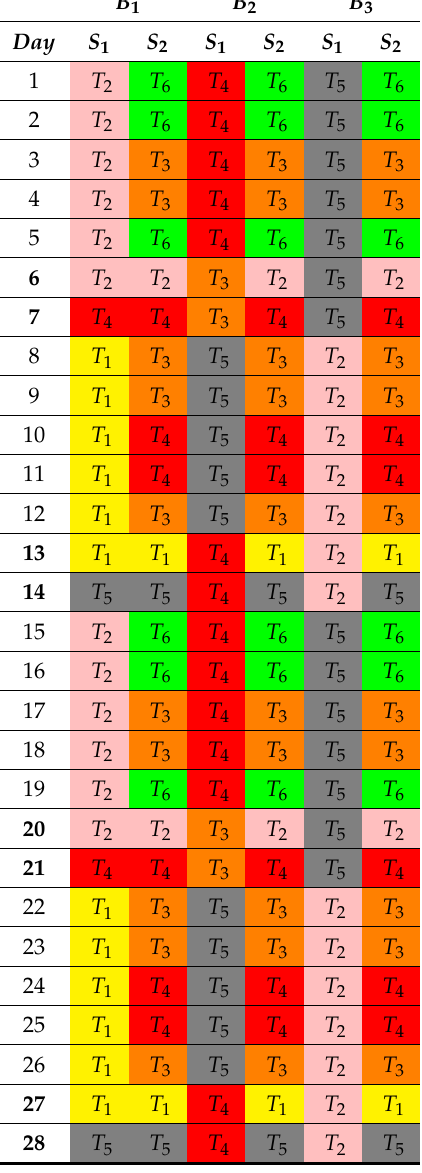
Table 2. Manual physician schedule for October. B 1 B